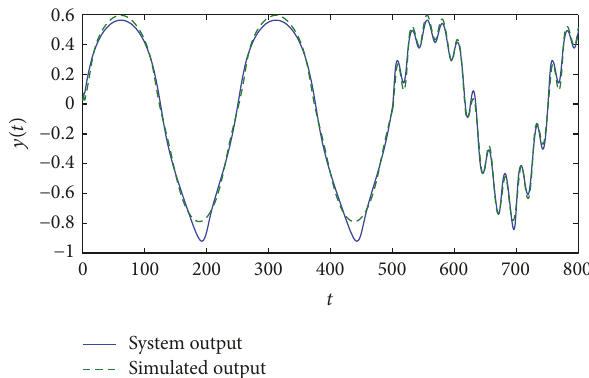
Figure 6: Simulated result with the quasi-ARX RBFN model for rational